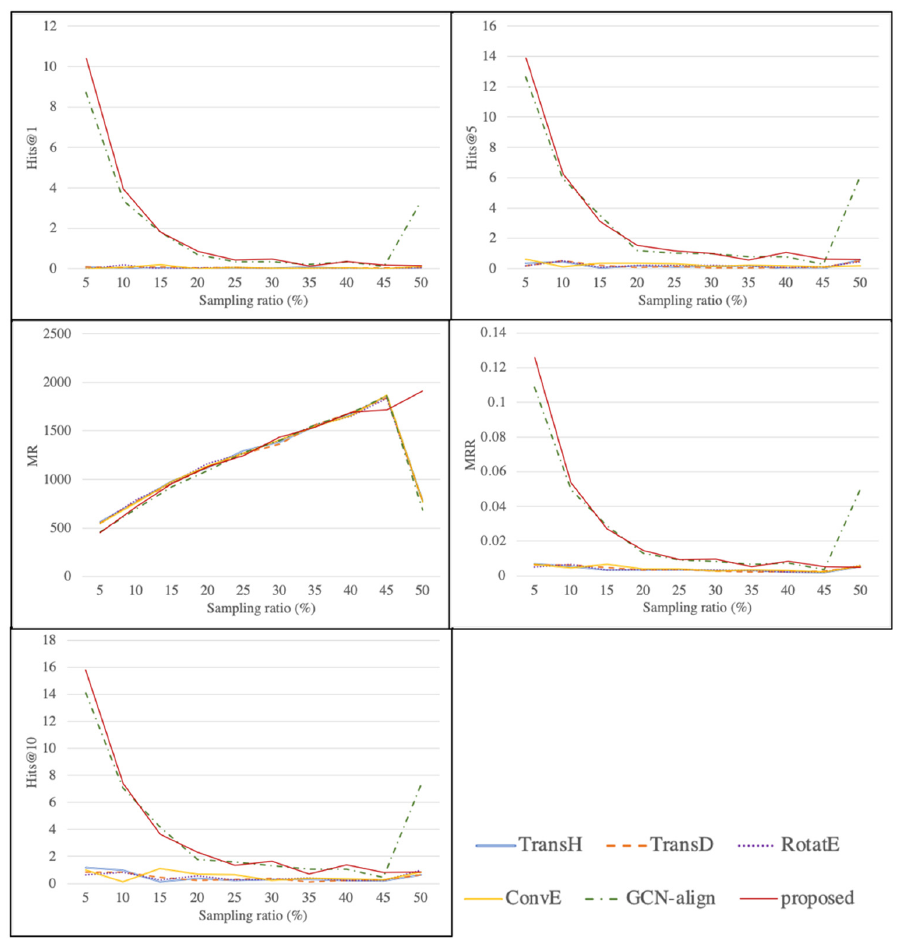
Figure 7. Comparison of knowledge graph alignment methods according to sampling ratio.